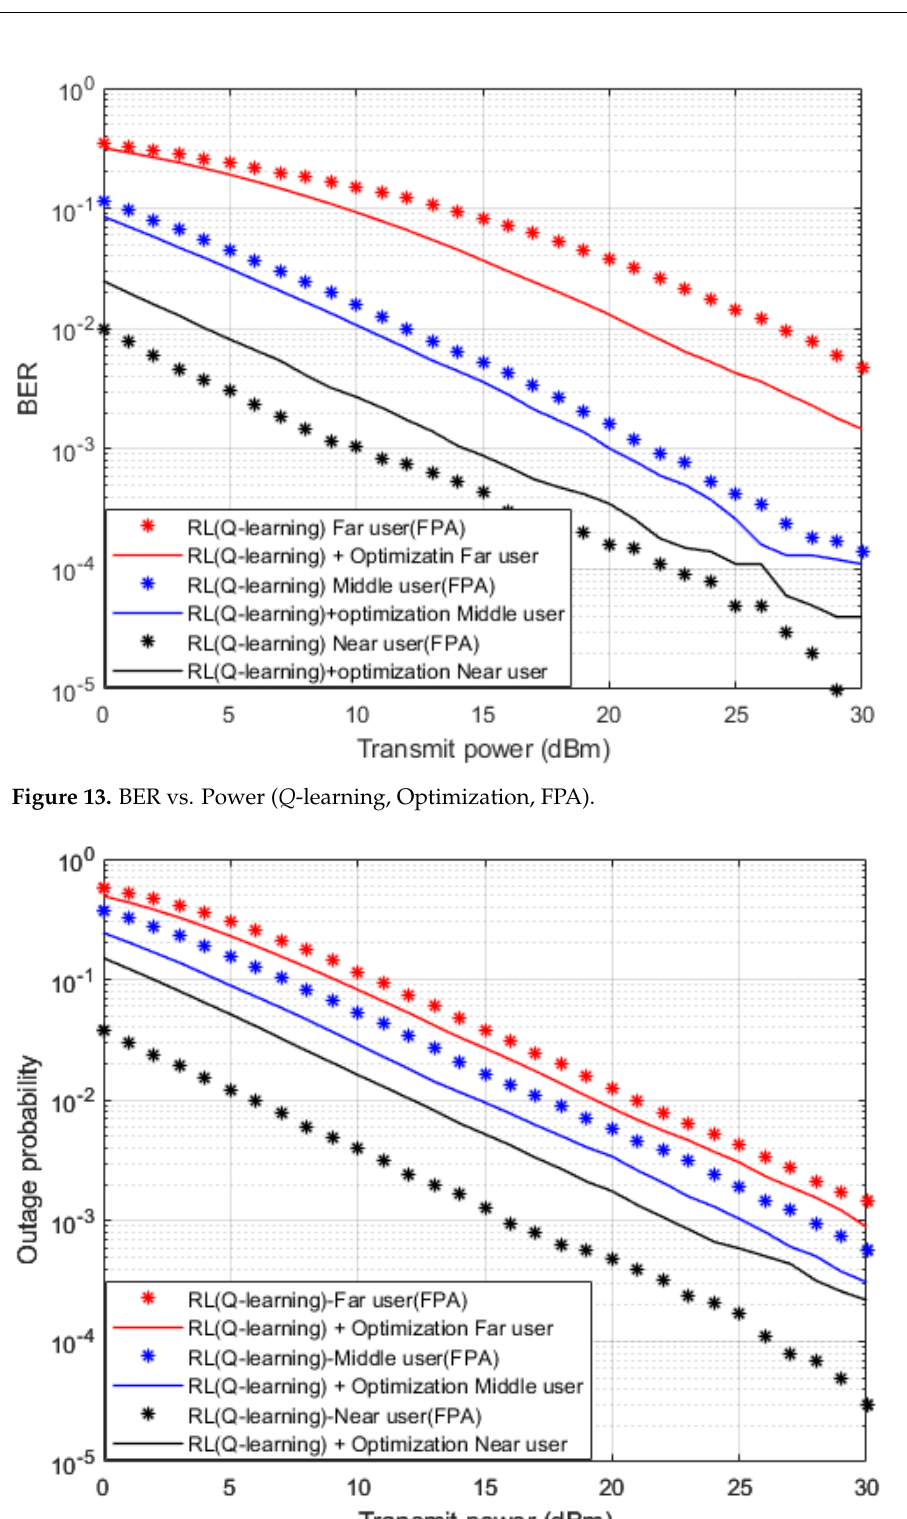
Figure 12. BER vs. Power ( Q ‐ learning, Conventional NOMA (MMSE) – Rician channel).